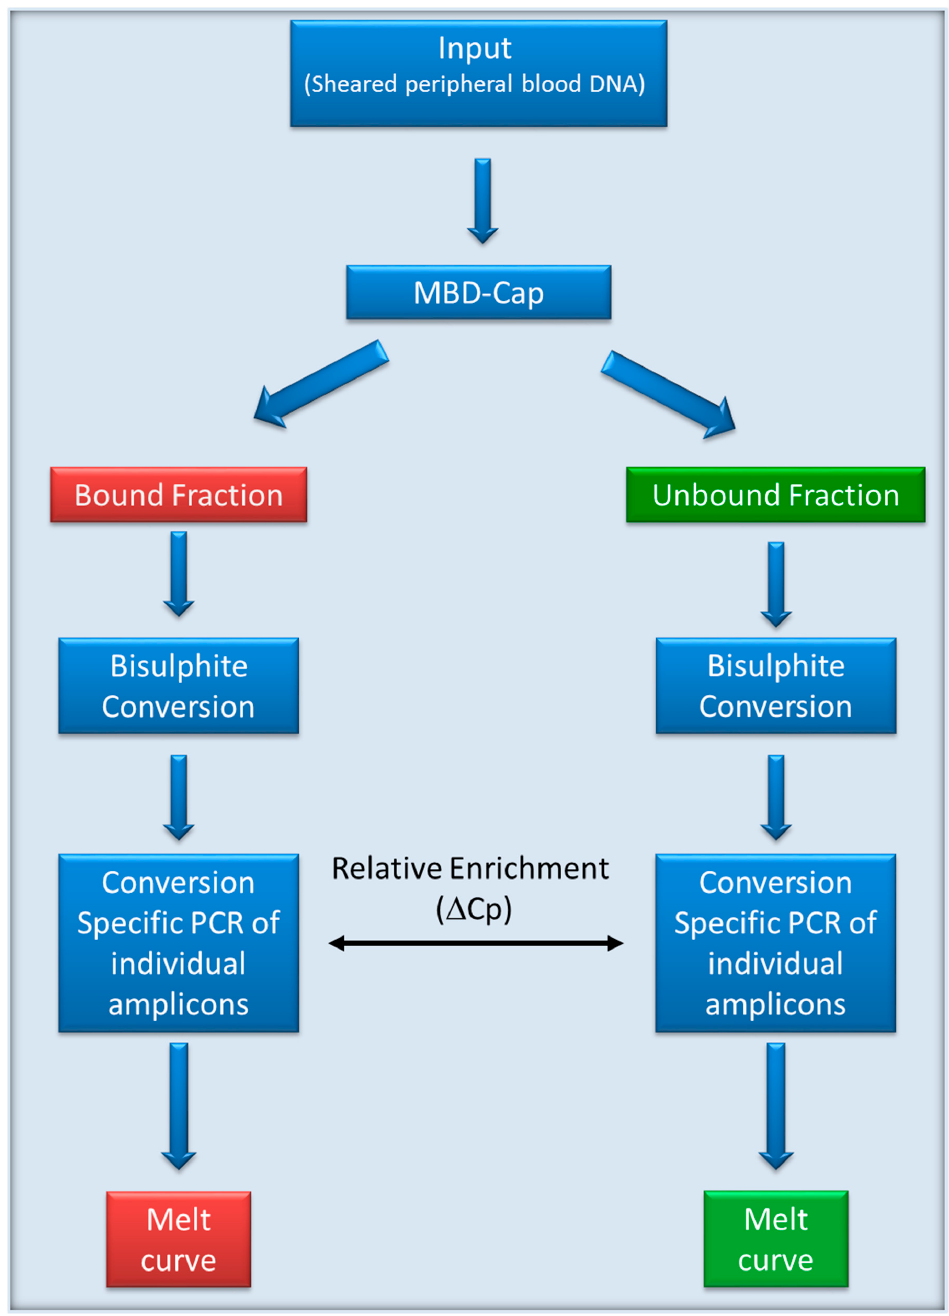
Figure 1. Flowchart for evaluation of methylation in white blood cell (WBC) DNA. DNA was sheared and the methylated fraction was isolated using methylated DNA binding domain-capture (MBD-Cap). The captured DNA and the unbound fraction were separately bisulphite converted. Separate conversion-specific PCRs for each gene were performed to amplify both methylated and unmethylated sequences from each of the bound and unbound